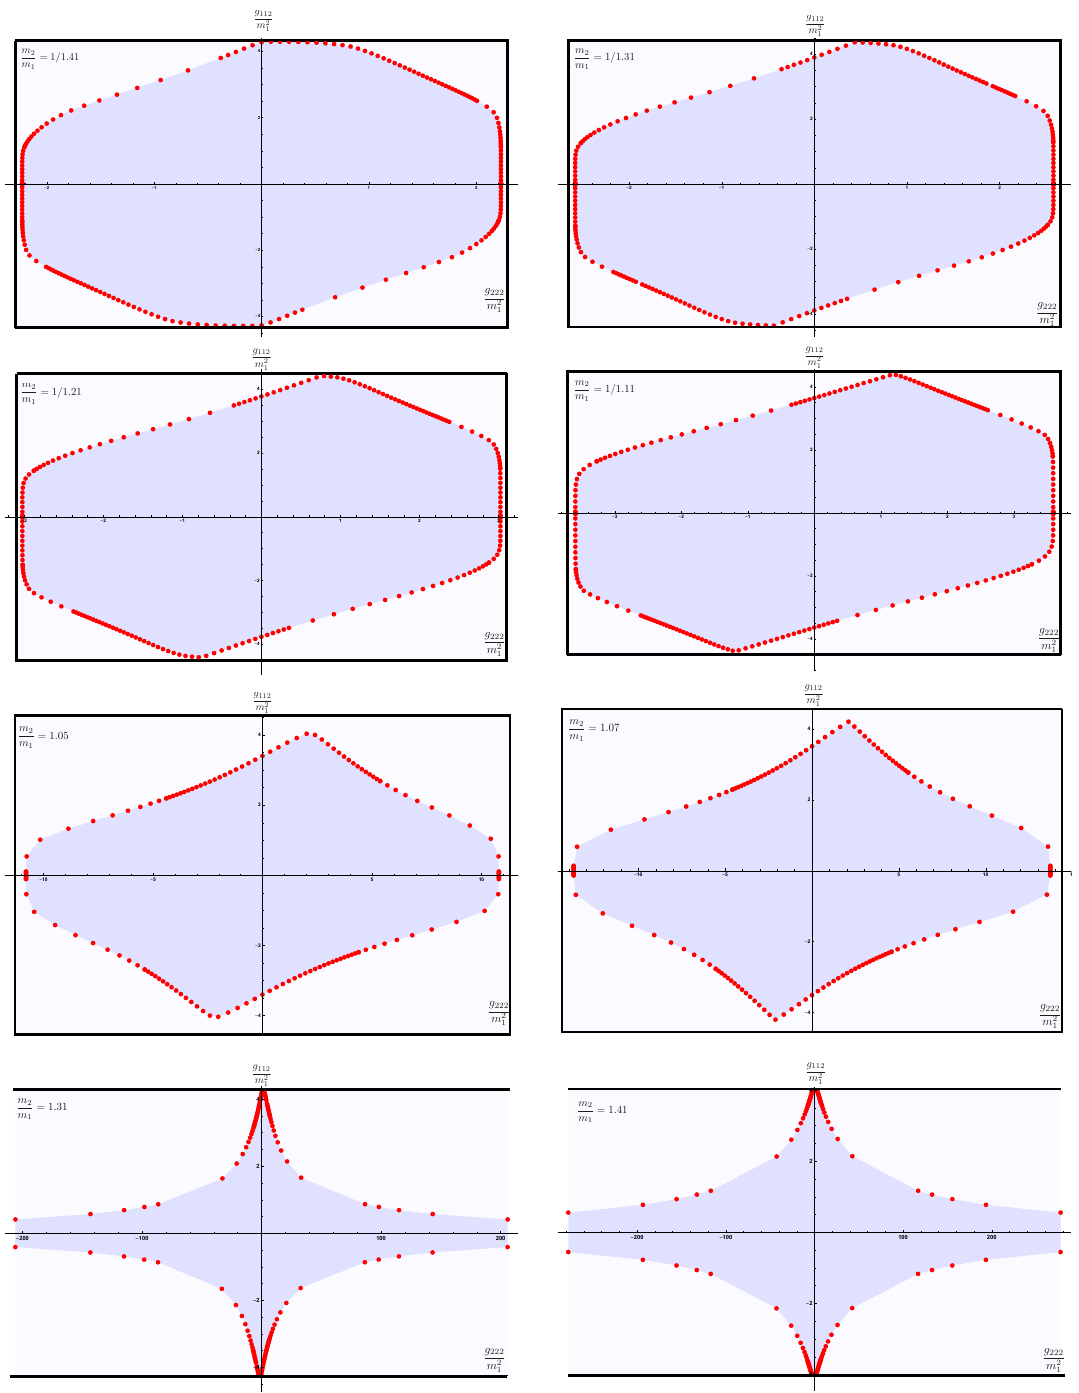
Figure 8. Space of allowed couplings for (cid:12)xed mass ratios. Horizontal and vertical solid lines: analytic bounds based on diagonal scattering derived in section 1. Red dots: the numeric bound obtained from all two-to-two processes. Features of the panels discussed in the main text.